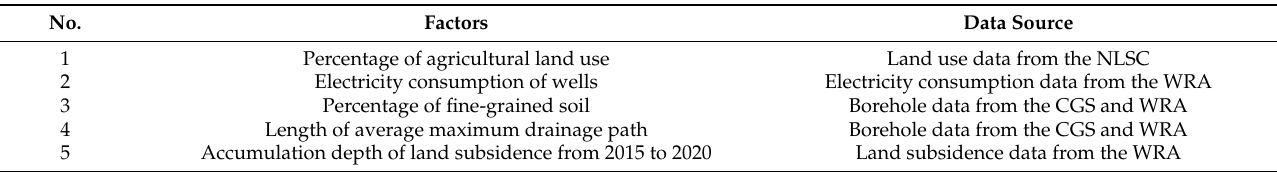
Table 3. The dominant environmental factors for land subsidence in this study.